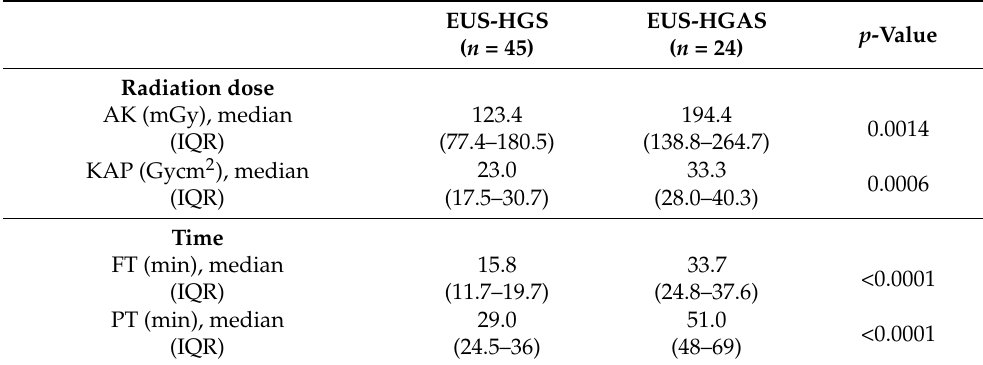
Table 2. Comparison of the radiation dose parameter (AK/DAP) and time factors (FT/PT) between EUS-HGS and EUS-HGAS.